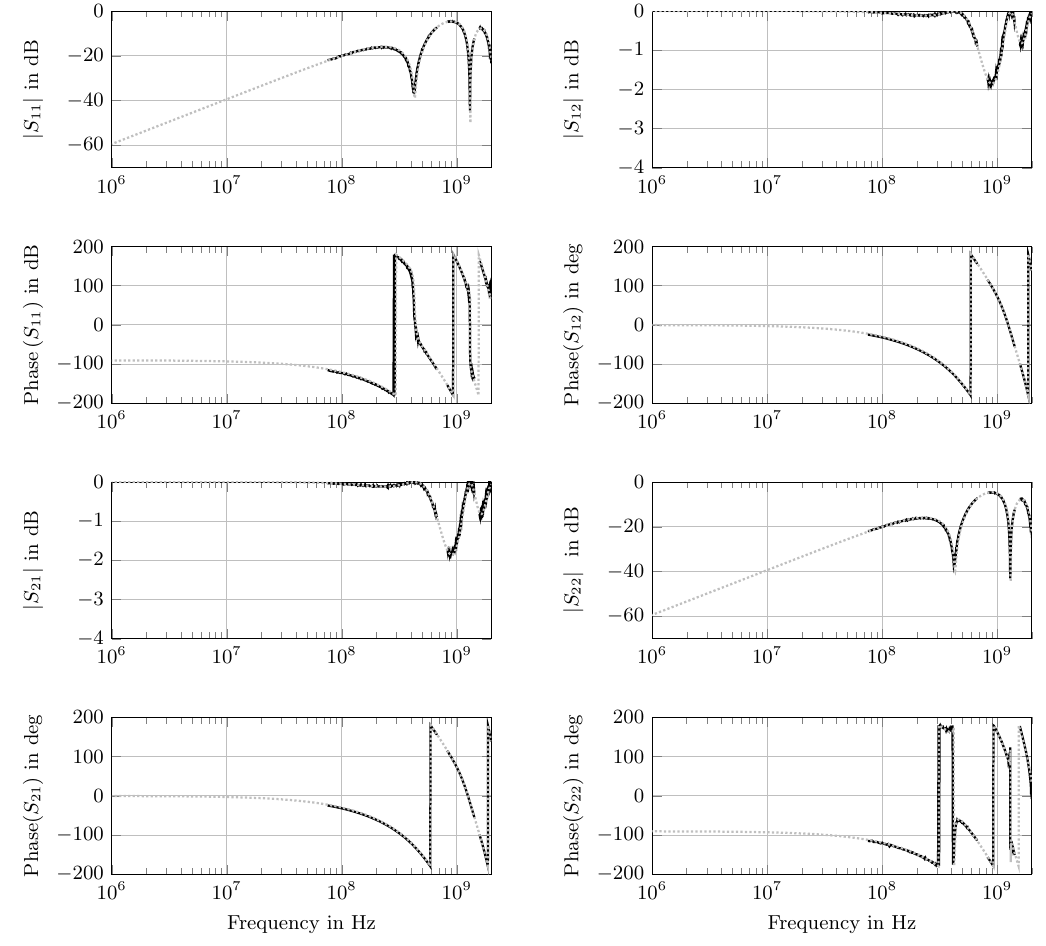
Figure 4. Scattering parameters S ij in magnitude and phase ( ) measured with the coaxial cell (three-layered setup: 50mm PTFE, 100mm air, 50mm PTFE) and the corresponding fit (